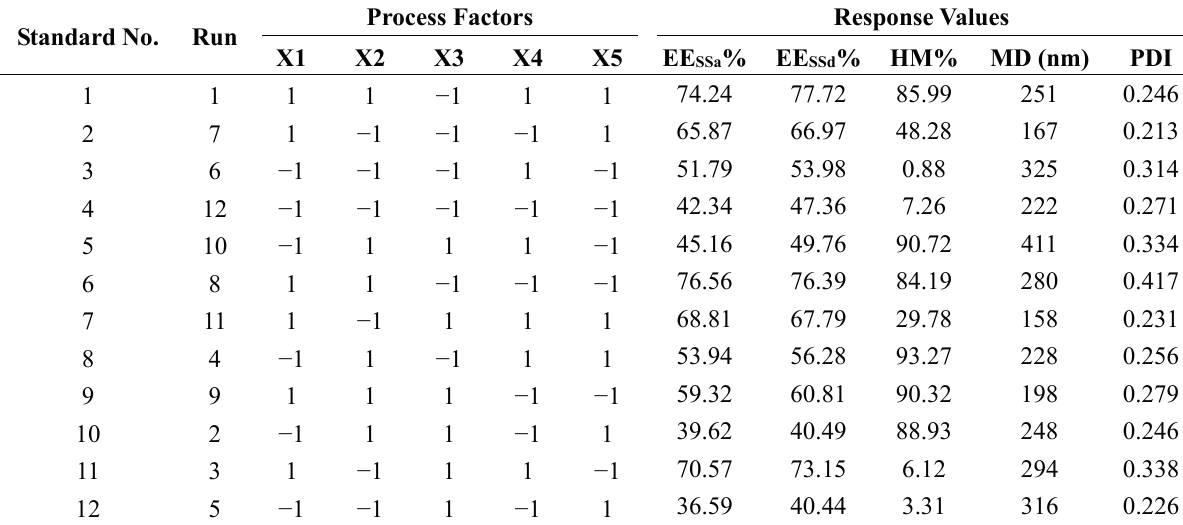
Table 3. Arrangement and results of the Placket-Burman design. Standard